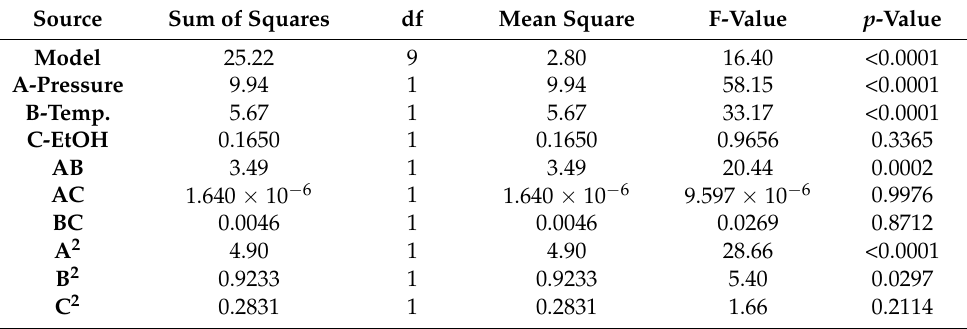
Table 2. Analysis of variance (ANOVA) for P. aeruginosa with quadratic model.